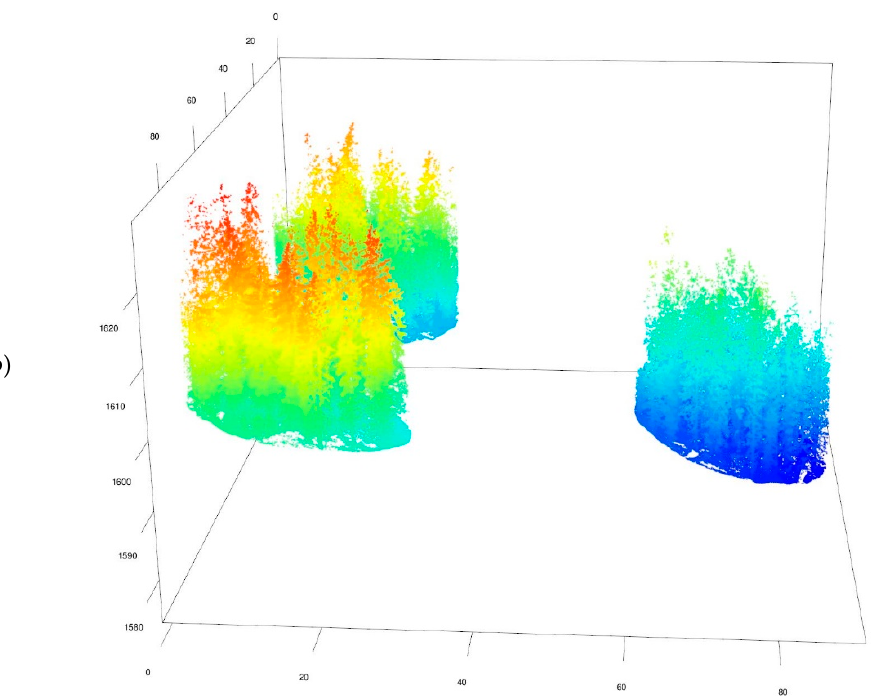
Figure 2. ( a ) TLS ground-based data collection ( b ) terrestrial laser scan of the